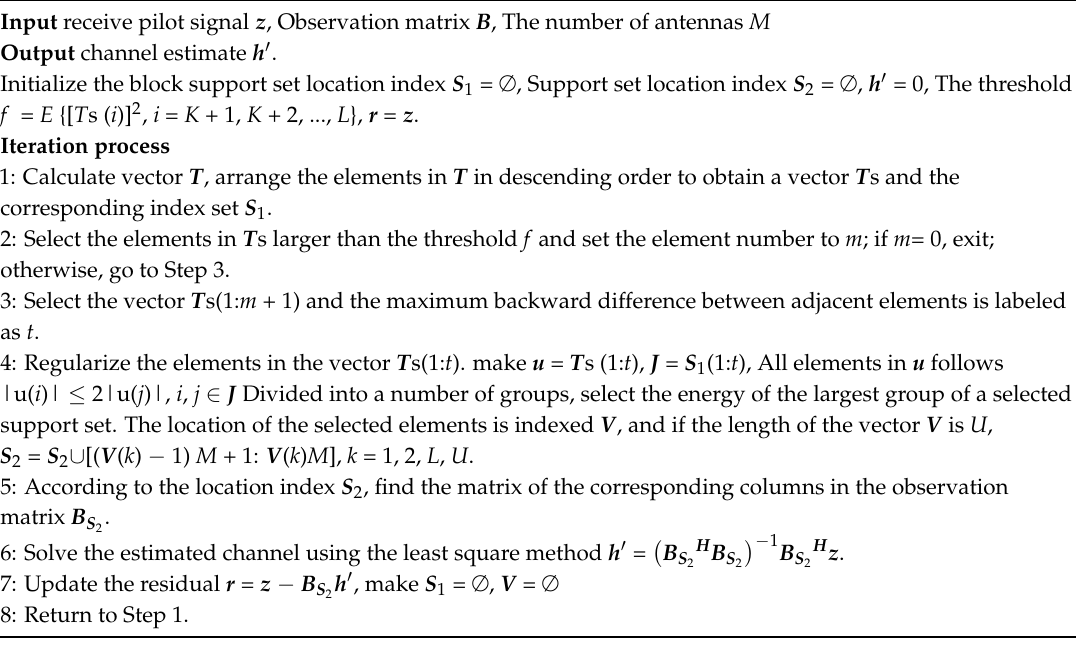
Algorithm 1 BSAMP Algorithm